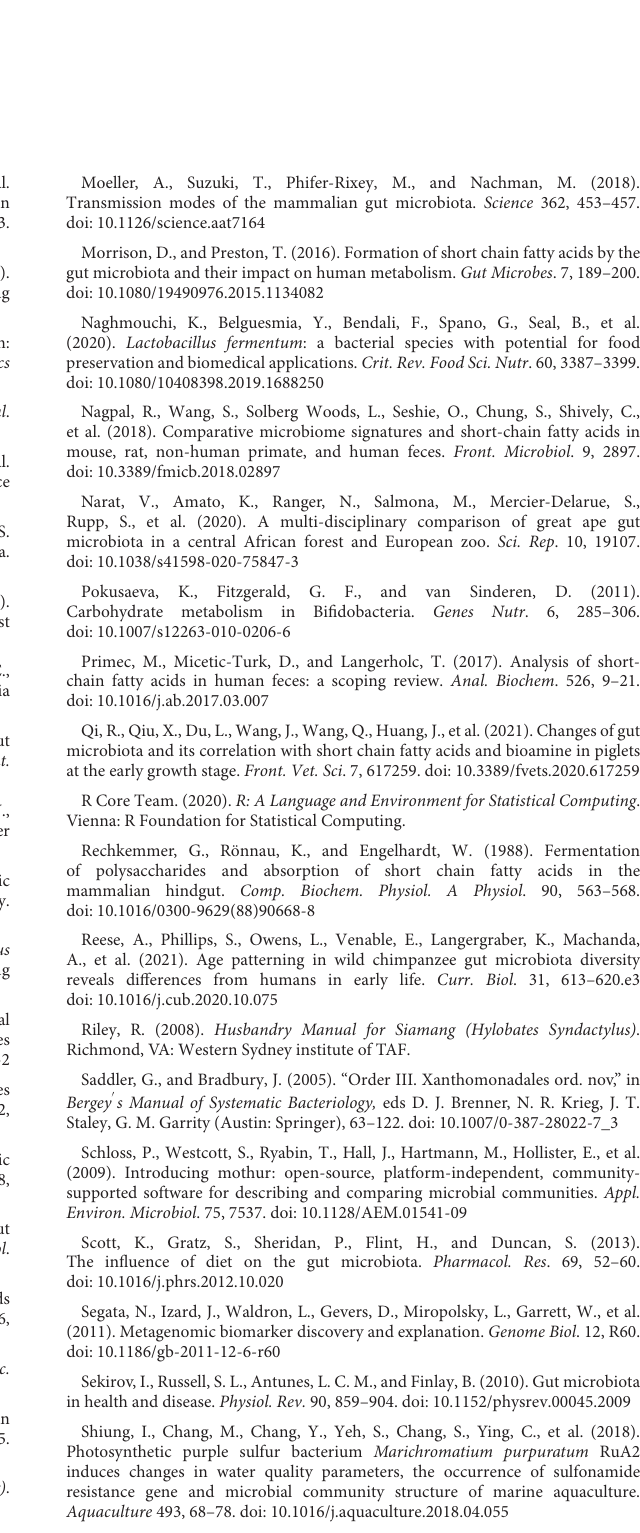
SUPPLEMENTARYTABLES2 The number of OUT identified in each sample. SUPPLEMENTARYTABLES3 Alpha-diversity of each sample